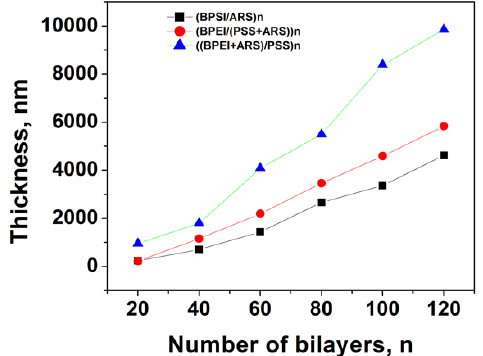
Figure 4. Relationship between the number of bilayers (or layer pairs) and thickness for when n is 20, 40, 60, 80, 100 and 120.